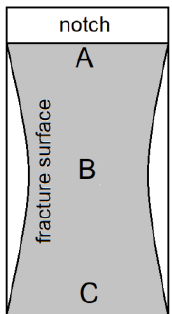
Figure 8. The KCV versus test temperature dependence for Cr-Mn-N steel.